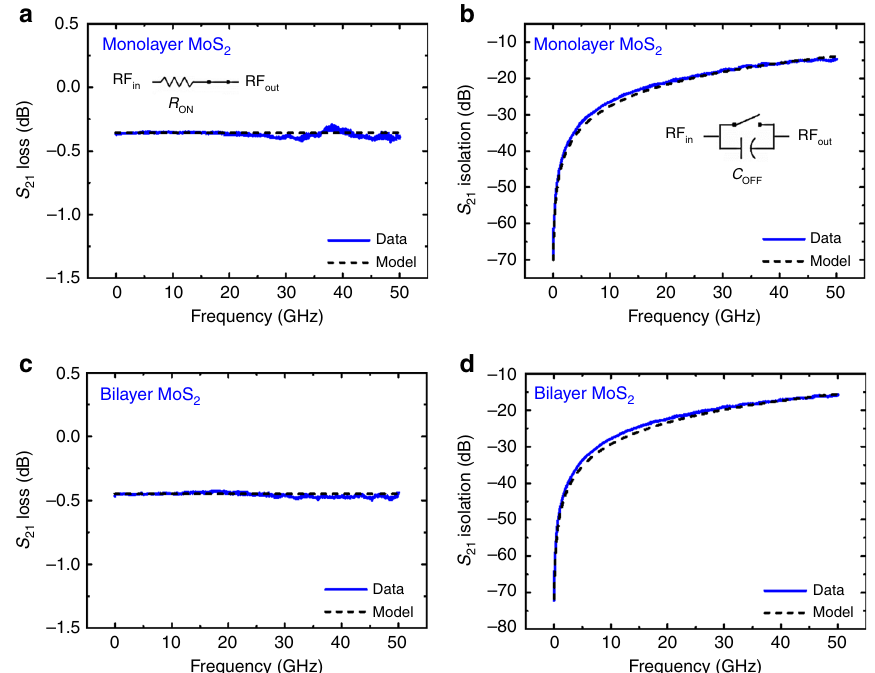
Fig. 3 Radio-frequency characterization of MoS 2 RF switches. a , b Experimental S(cattering)-parameter data in both the ON-state (insertion loss) and OFF- state (isolation) of an RF switch based on 0.5 × 0.5 μ m 2 monolayer MoS 2 atomristor. The extracted R ON and C OFF values are 4.2 Ω and 6.5 fF, respectively. c , d S-parameter insertion loss and isolation data of an RF switch based on 0.5 × 0.5 μ m 2 bilayer MoS 2 atomristor. R ON is 5.3 Ω and C OFF is 5.4 fF. The dashed lines are derived from an equivalent circuit model